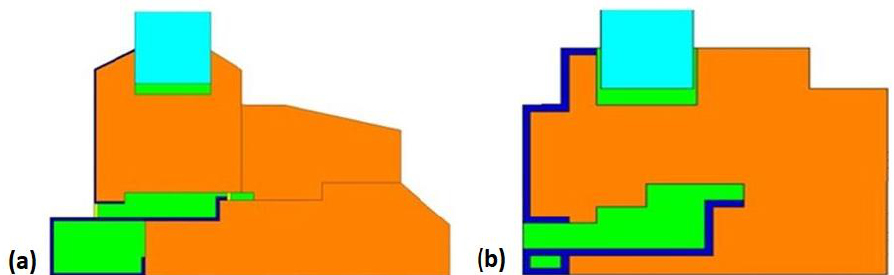
Figure 2. Wooden frame: simplified geometry ( a ), and geometry based on the generic frame (GF) ( b ). Finite element simulations in 2D indicate a maximum 3 percent difference in U-factor between the original simplified model and GF.